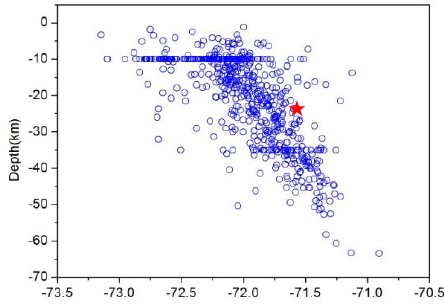
Figure 7. Distribution of aftershock depths in the direction of longitude (aftershocks from http://earthquake.usgs.gov, as of 11/10/2015), Red stars indicate the Global CMT epicenter of